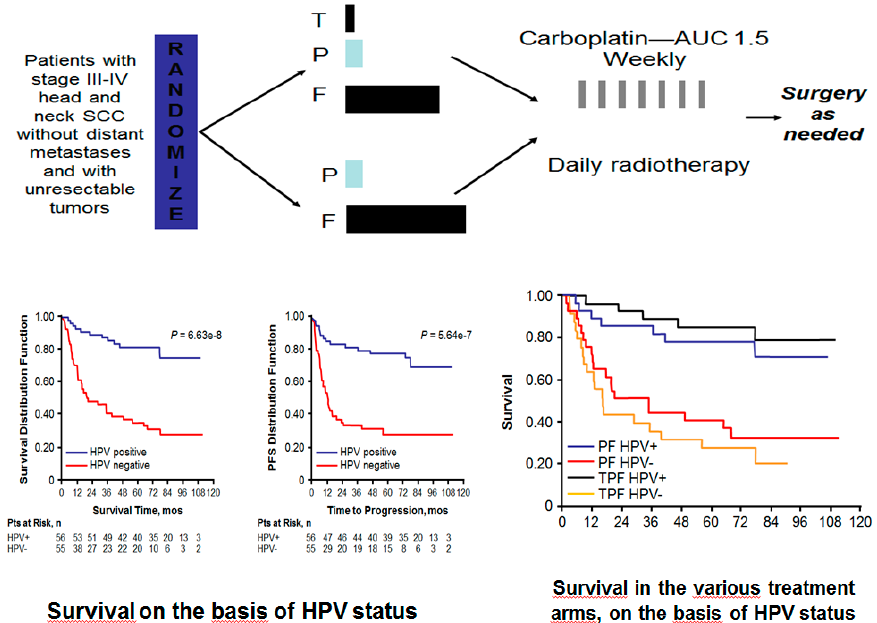
Figure 3. The subgroup analysis of Tax342 study revealed that HPV-positive patients treated with both induction TPF and induction PF performed better when compared with those who were HPV-negative, suggesting that HPV positivity could be considered a factor predictive of good response to sequential chemoradiotherapy. Source: Fakhry C et al. J. Natl. Cancer Inst., 2008 , 100 , 261–269 [61]. PF: cisplatin-